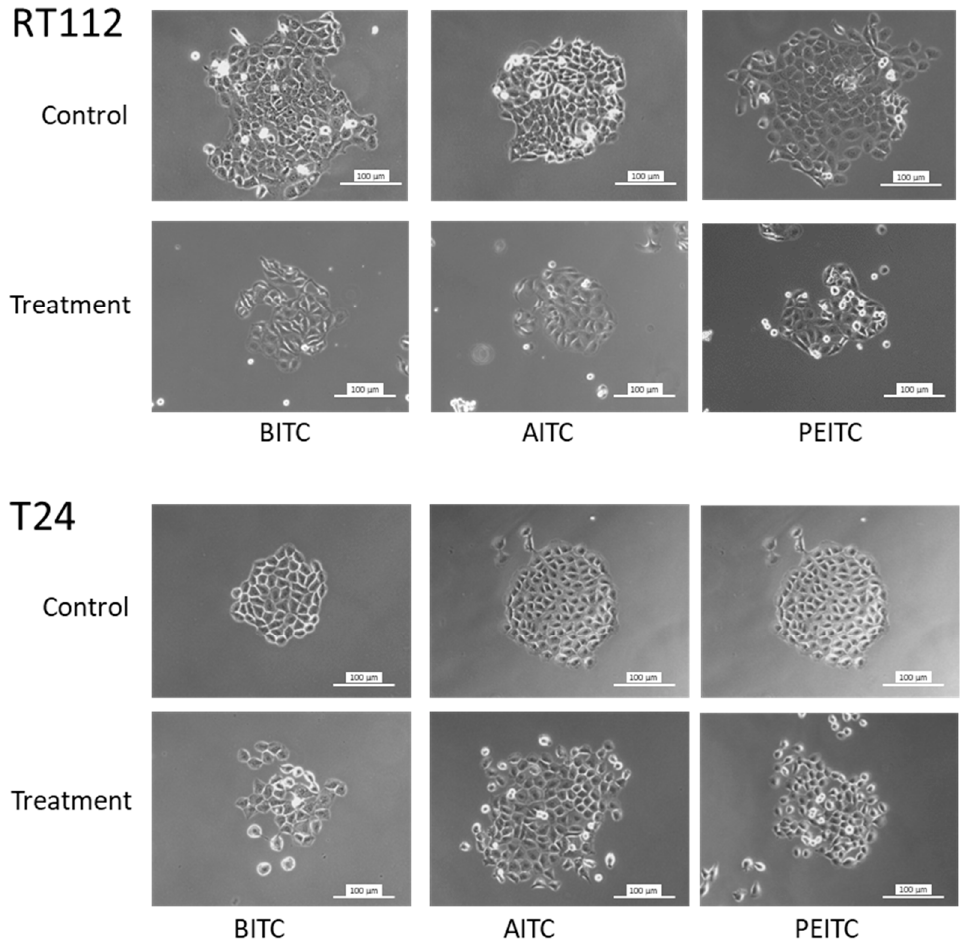
Figure 5. Influence of BITC (7.5 µM), AITC (20 µM) and PEITC (7.5 µM) on clone formation of parental RT112 and T24 cells. Controls were without drugs. Scale bar: 100 µm.